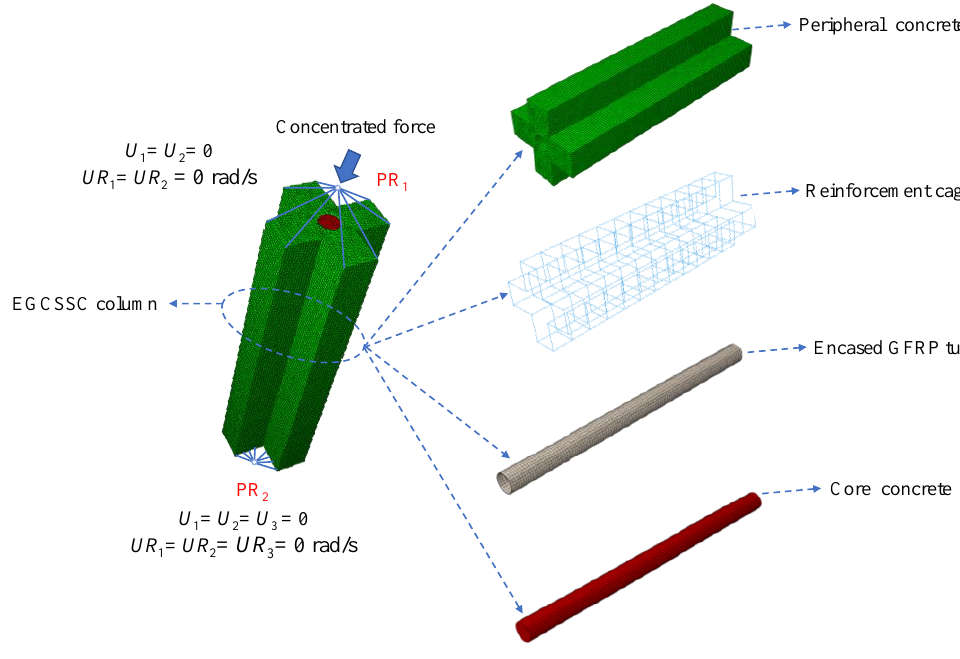
Figure 3. The finite element model of EGCSSCs.